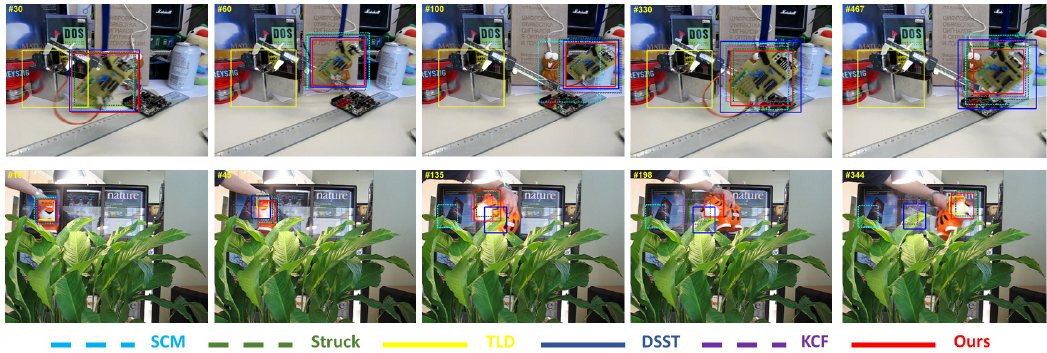
Figure 7. Screenshots of some tracking results in deformation sequences. These frames are extracted from sequences board and tiger2 , from top to